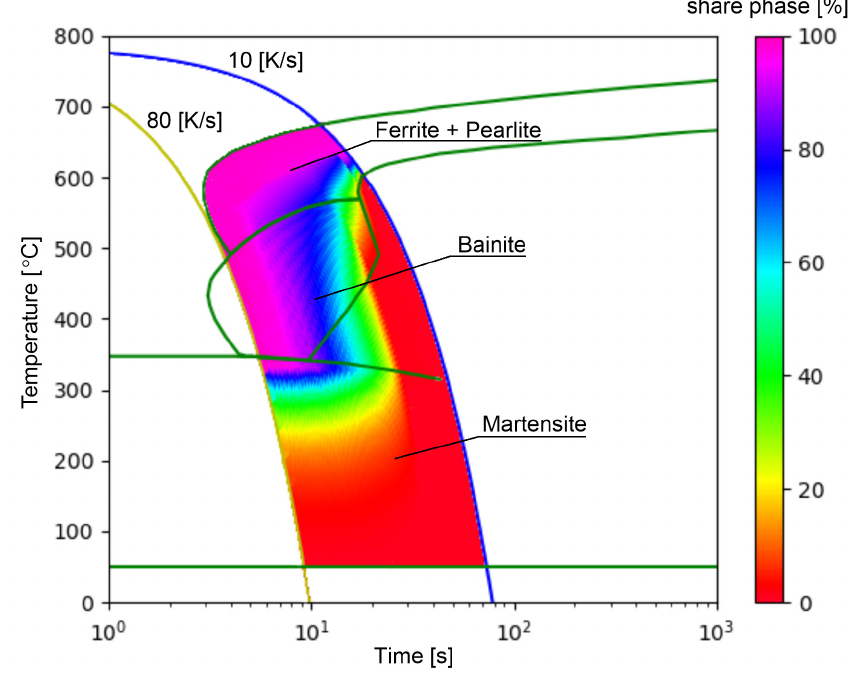
Figure 3. CTP diagram divided into analysed ranges—input/output data for